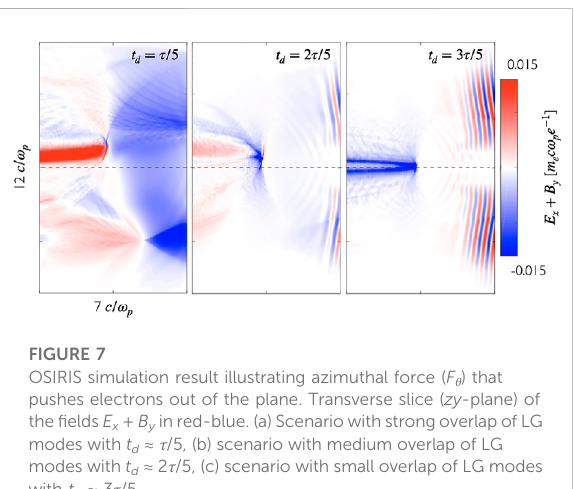
FIGURE 7 OSIRIS simulation result illustrating azimuthal force ( F θ ) that pushes electrons out of the plane. Transverse slice ( zy -plane) of the fi elds E x + B y inred-blue.(a)Scenariowith strongoverlapofLG modes with t d ≈ τ /5, (b) scenario with medium overlap of LG modes with t d ≈ 2 τ /5, (c) scenario with small overlap of LG modes with t d ≈ 3 τ